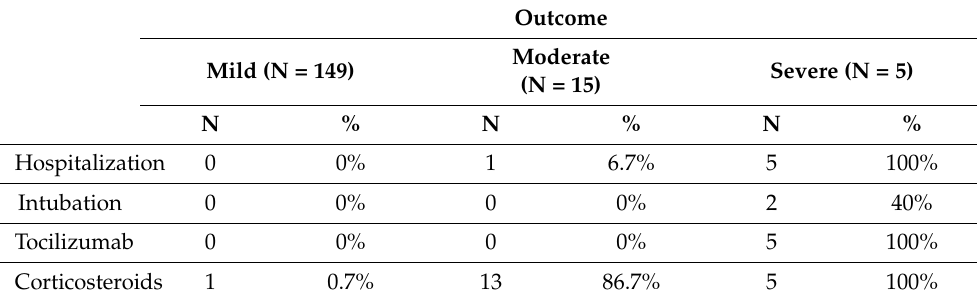
Table 3. Patients’ responses to the treatment for SARS-CoV-2 infection (hospitalized or non- hospitalized patients).